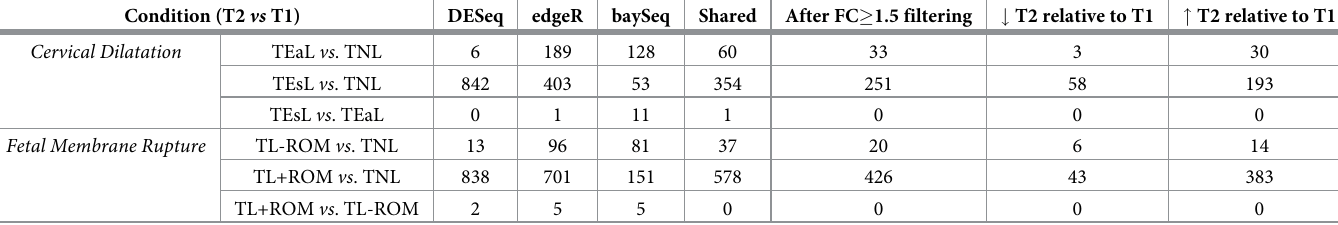
Table 5. Number of differentially expressed genes in human myometrium identified by RNA-seq for different labour states. Condition (T2 vs T1) DESeq edgeR baySeq Shared After FC � 1.5 filtering # T2 relative to T1 " T2 relative to T1 Cervical Dilatation TEaL vs . TNL 6 189 128 TEsL vs . TNL 842 TEsL vs . TEaL 0 Fetal Membrane Rupture TL-ROM vs . TNL 13 96 TL+ROM vs . TNL 838 TL+ROM vs . TL-ROM Down-regulated ( # ) and up-regulated ( " ) genes during term (37 +3 –41 +1 weeks) gestation singleton pregnancy/labour; labour status defined at time of Caesarean